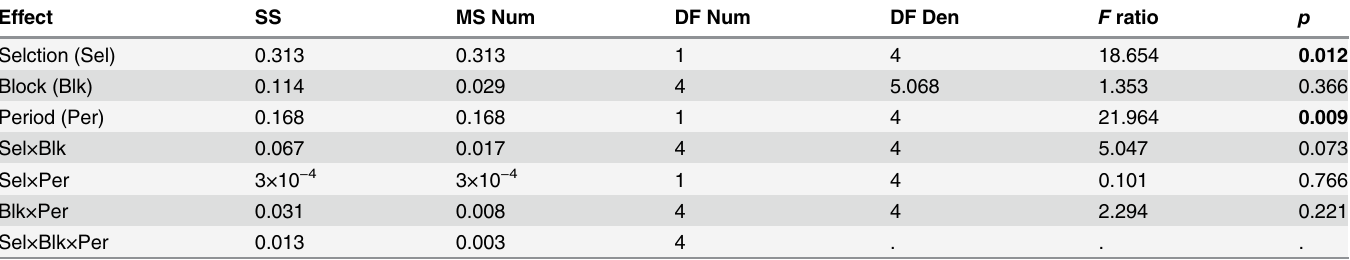
Table 4. Proportion of ancestral females that produced progeny after exposing with cold shocked males. Summary of results from a three-factor ANOVA on proportion of females that produced progeny (post mating with FSB or FCB males) using selection regime (FSB and FCB), period (recovery period 4 hours and 12 hours post cold shock) as fixed factors crossed with block (1 – 5) as random factor. p -values in bold are statistically significant.